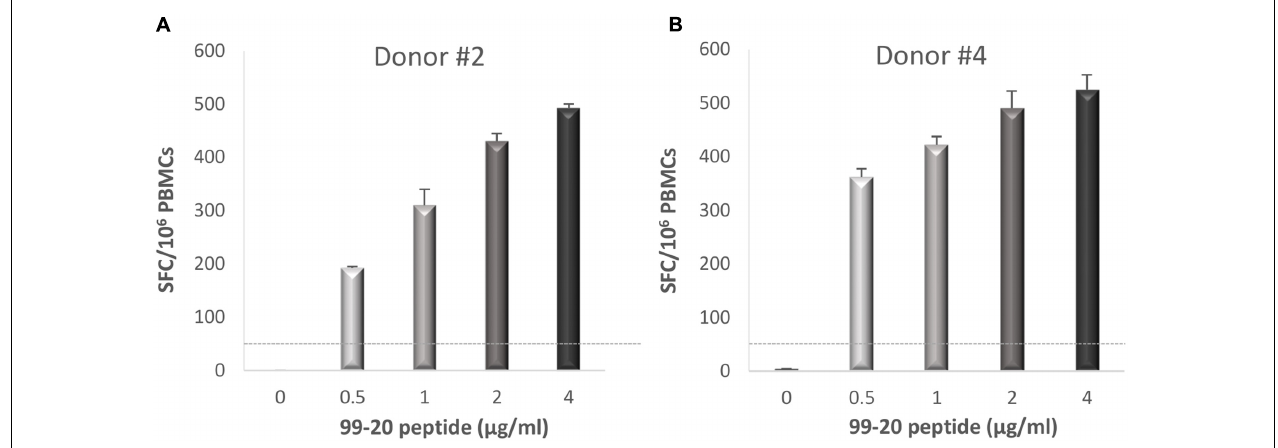
FIGURE 6 | Enzyme-linked immunosorbent spot IFN- γ responses toward NoV GII.4-1999 T cell epitope 99-20. Fresh peripheral blood mononuclear cells (PBMCs) of donors #2 (A) and #4 (B) were stimulated with an increasing concentration (0–4 µ g/ml) of peptide 99-20 containing the putative NoV-specific T cell epitope. Shown are the spot-forming cells (SFC)/10 6 PBMCs of two replicate wells with standard errors of the mean. The cut-off line (dotted line) represents the positive SFC/10 6 value of > 50 SFC/10 6 cells.